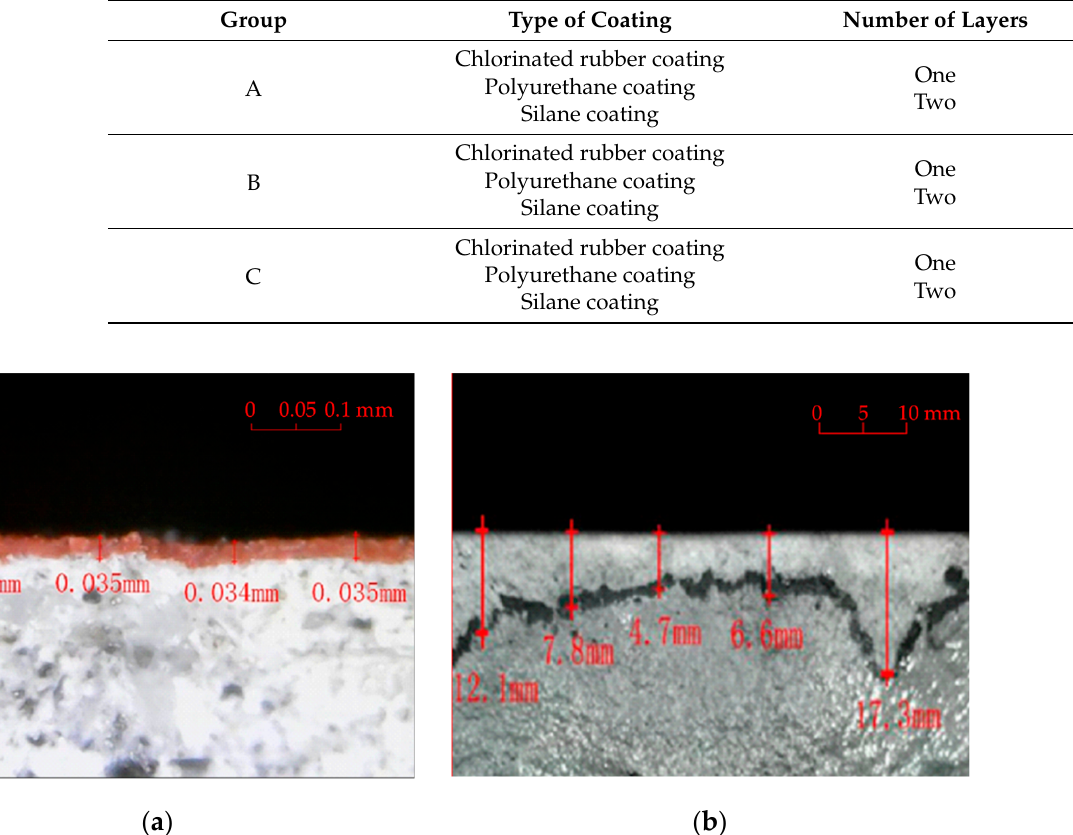
Figure 2. Polymer coating thickness. ( a ) Coating thickness of the chlorinated; ( b ) Coating thickness of silane rubber and polyurethane